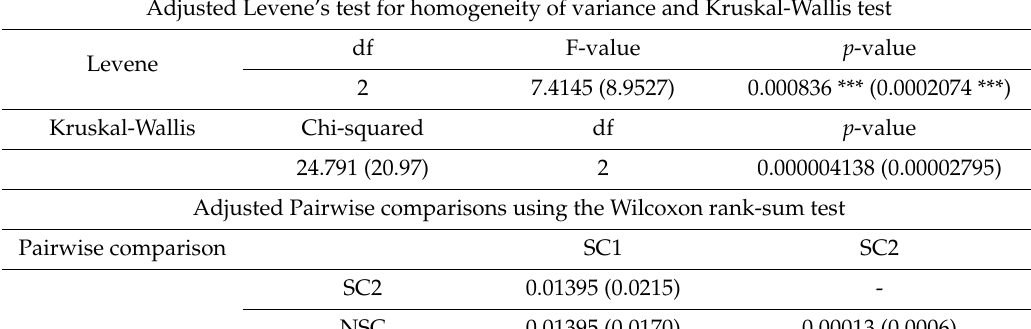
Table 12. Adjusted Levene’s test, Kruskal-Wallis test, and the Wilcoxon rank-sum